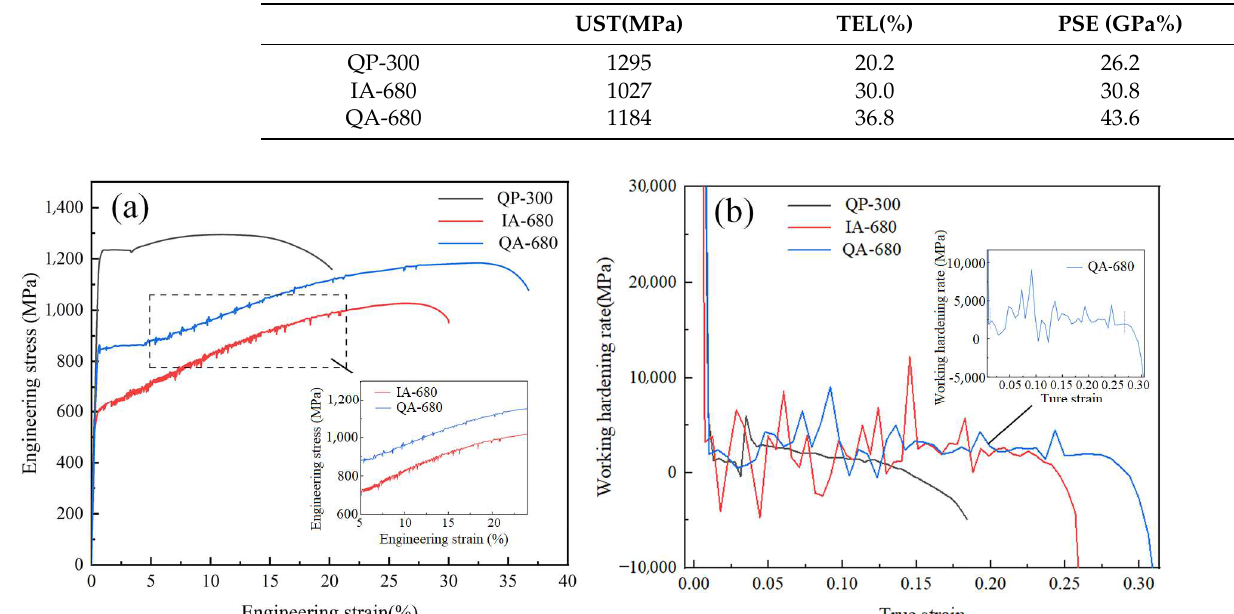
Figure 5. ( a ) Stress-strain curves and ( b ) working hardening rate